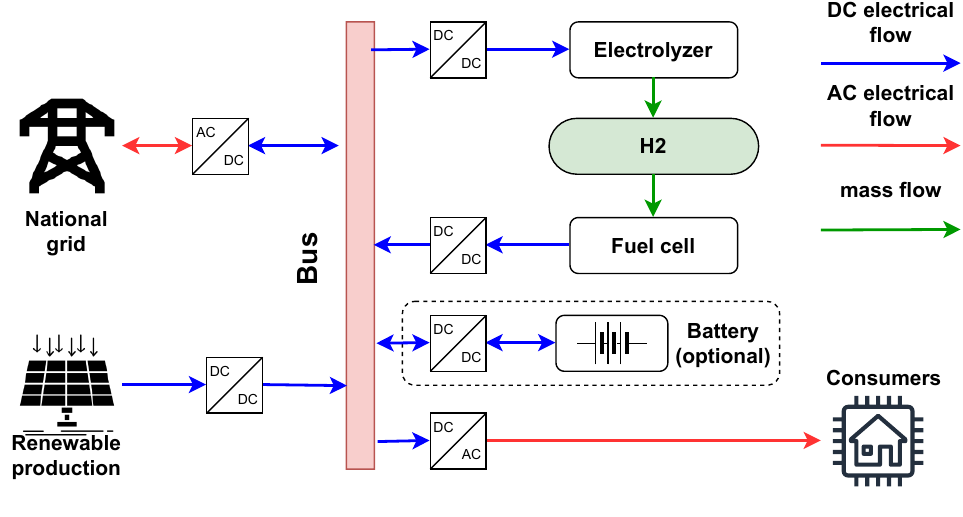
Figure 2. First case